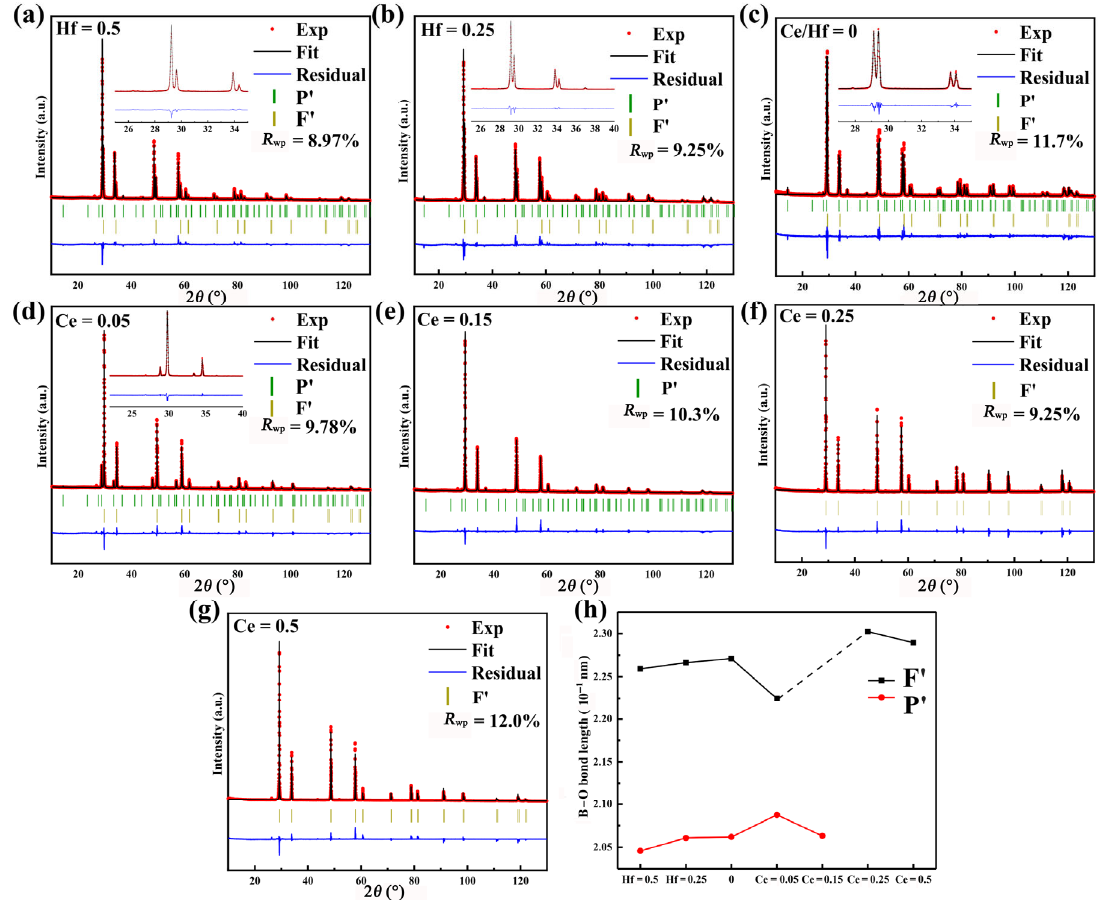
Fig. 1 XRD refinement of A 2 B 2 O 7 high-entropy ceramics: (a–g) XRD refinement results; (h) B–O length of P' and